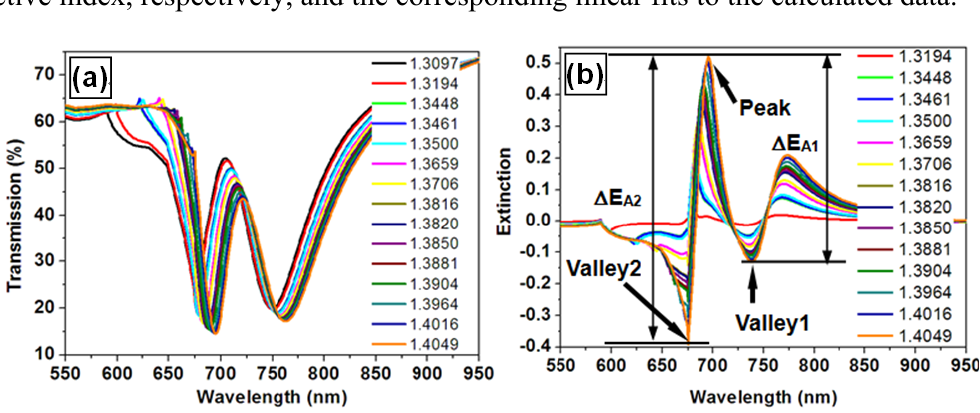
indices; ( b ) The spectra of the sensor signal at different environmental refractive